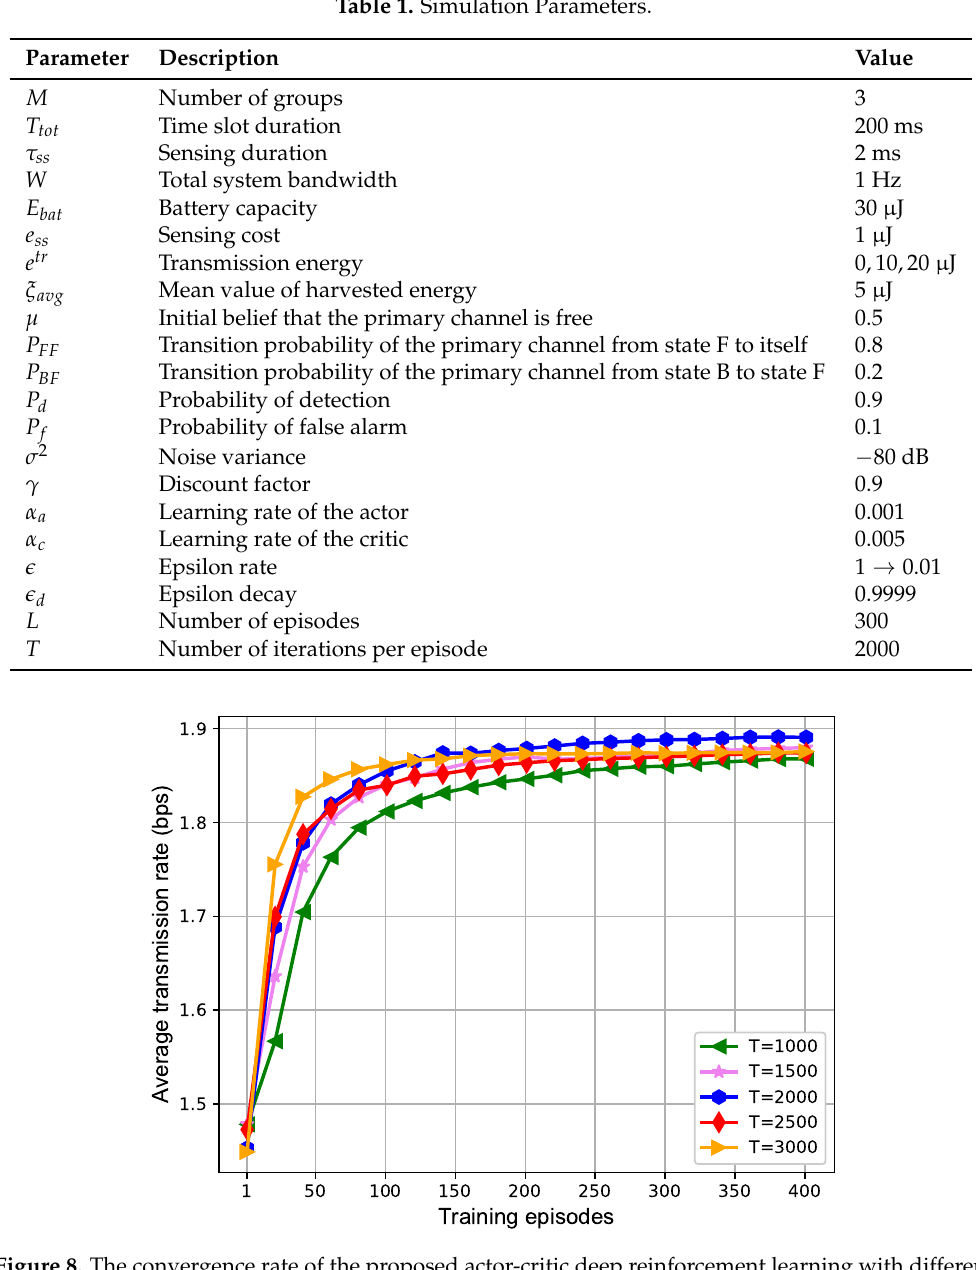
Figure 8. The convergence rate of the proposed actor-critic deep reinforcement learning with different training steps in each